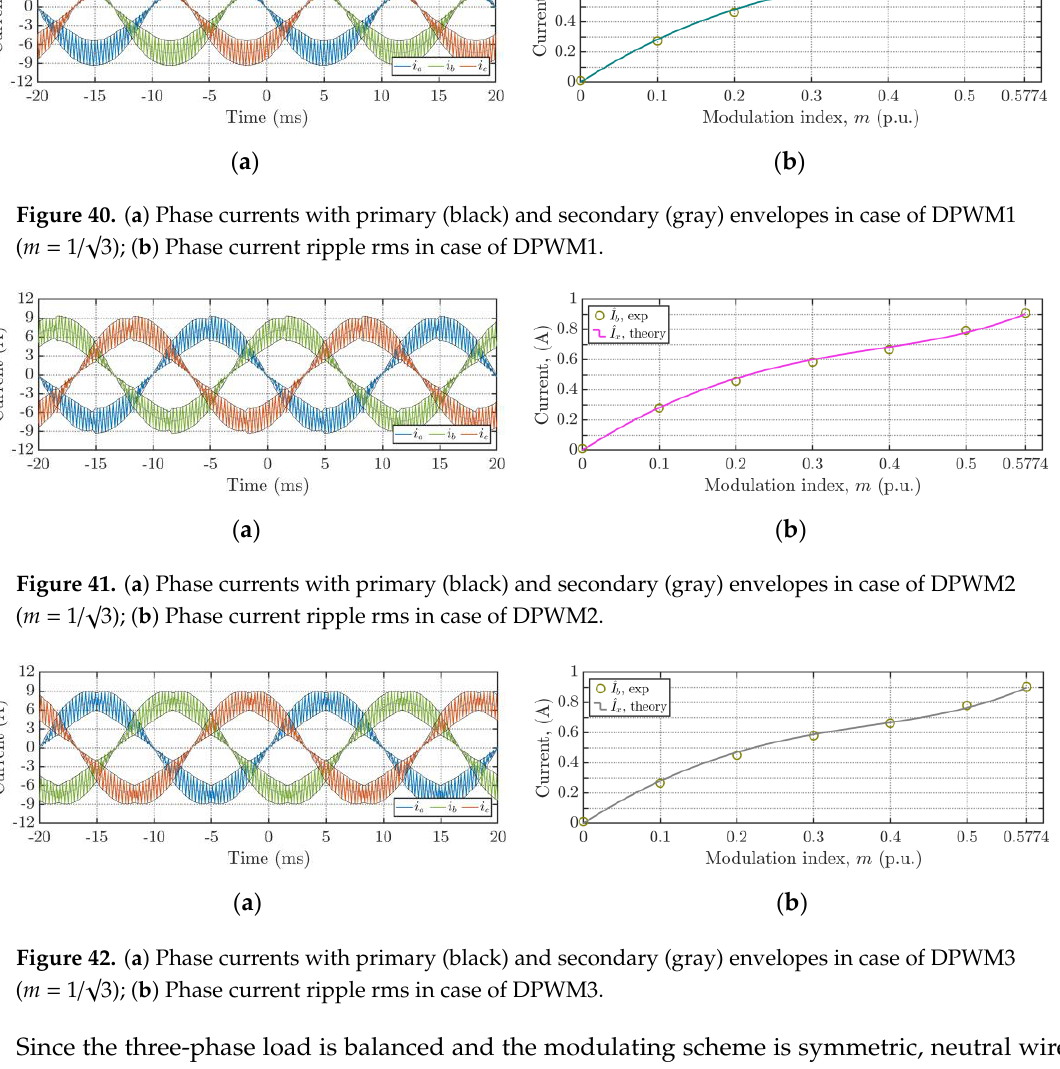
( m = 1/√3); ( b ) Phase current ripple rms in case of DPWM0.